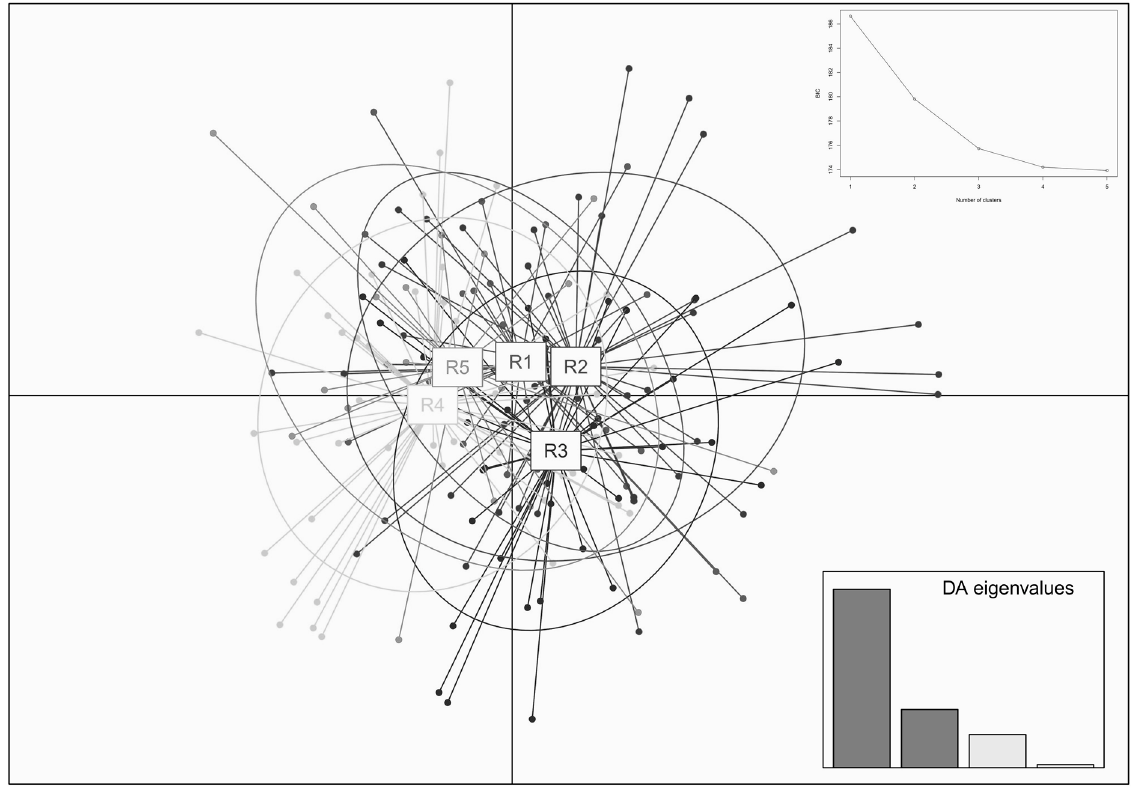
Figure 5. Genetic clusters with DAPC method for red deer based on microsatellite data. The figure included the cluster graph of individuals from each group and the broken line graph corresponding to the cluster number K and BIC values.